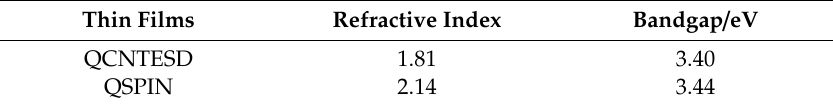
Table 4. Refractive index and optical bandgap of the heat-treated thin films on the quartz glass substrate prepared via the ESD and spin-coating processes, QCNTESD and QSPIN. The bandgap was obtained based on the assumption of the indirect transition.